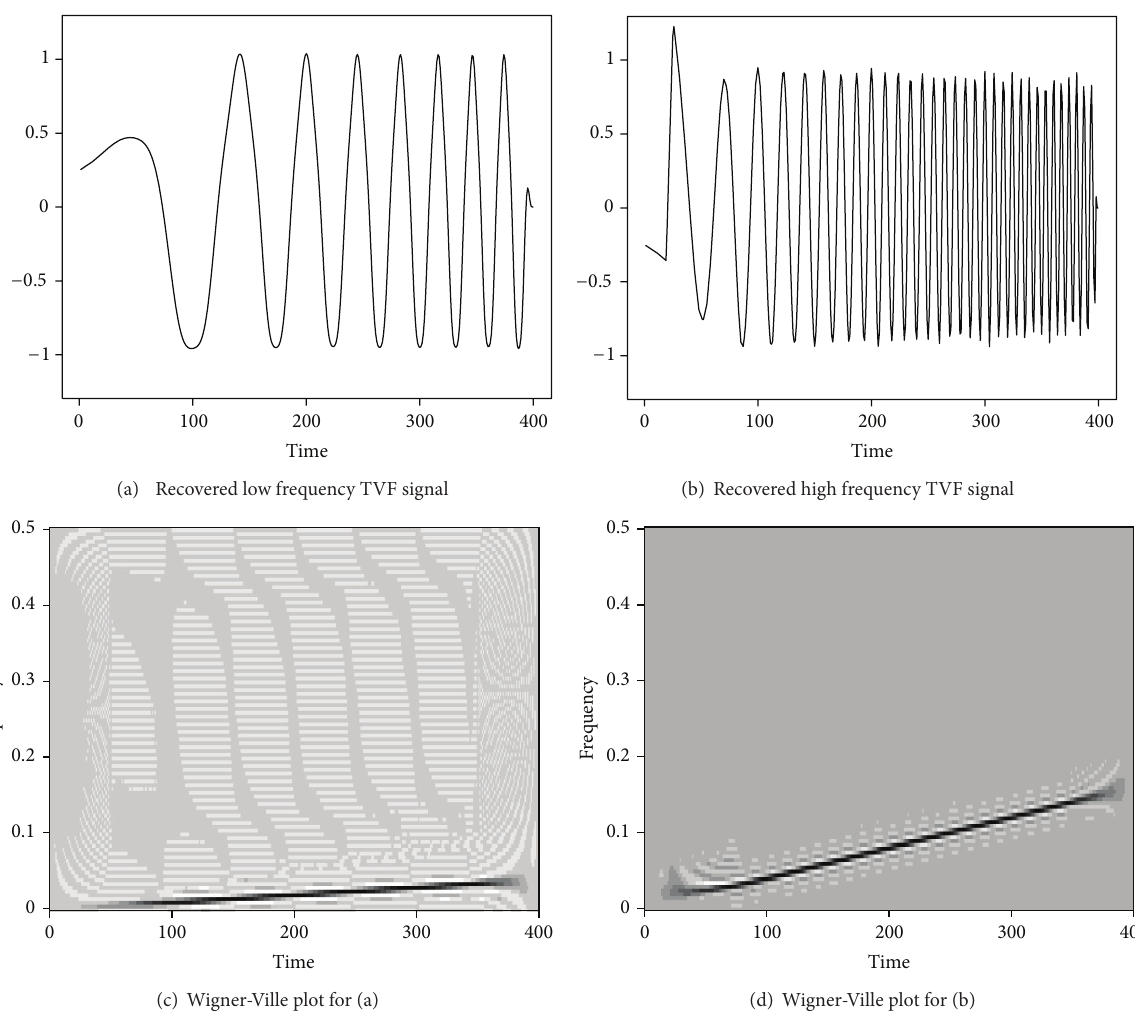
Figure 3: (a) Recovered low frequency TVF component; (b) recovered high frequency TVF component; (c) Wigner-Ville plot for (a); (d) Wigner-Ville plot for